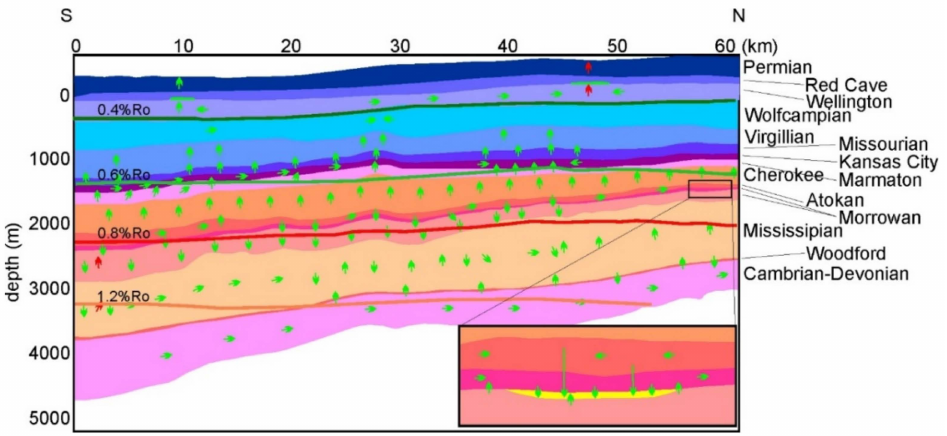
Figure 15. Vitrinite reflectance and liquid (green) and gas (red) migration pathways predicted by Schlumberger Petromod ® software. The Morrowan formation is divided into an Upper and Lower Morrow shale. The black box is enlarged in the inset; the reservoir sandstone formation (yellow) is charged by the Upper and Lower Morrowan shales, the Woodford, and the Thirteen Finger